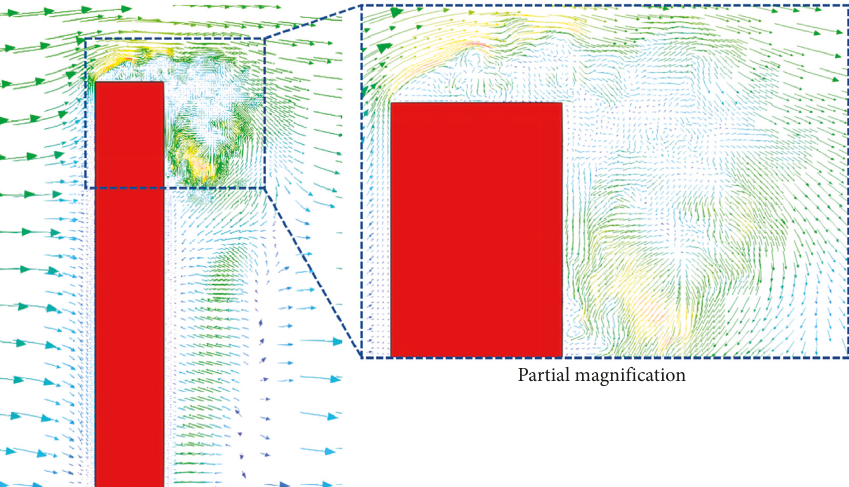
Figure 8: Velocity distribution of the wale model of class D wind farm passing through the center line of